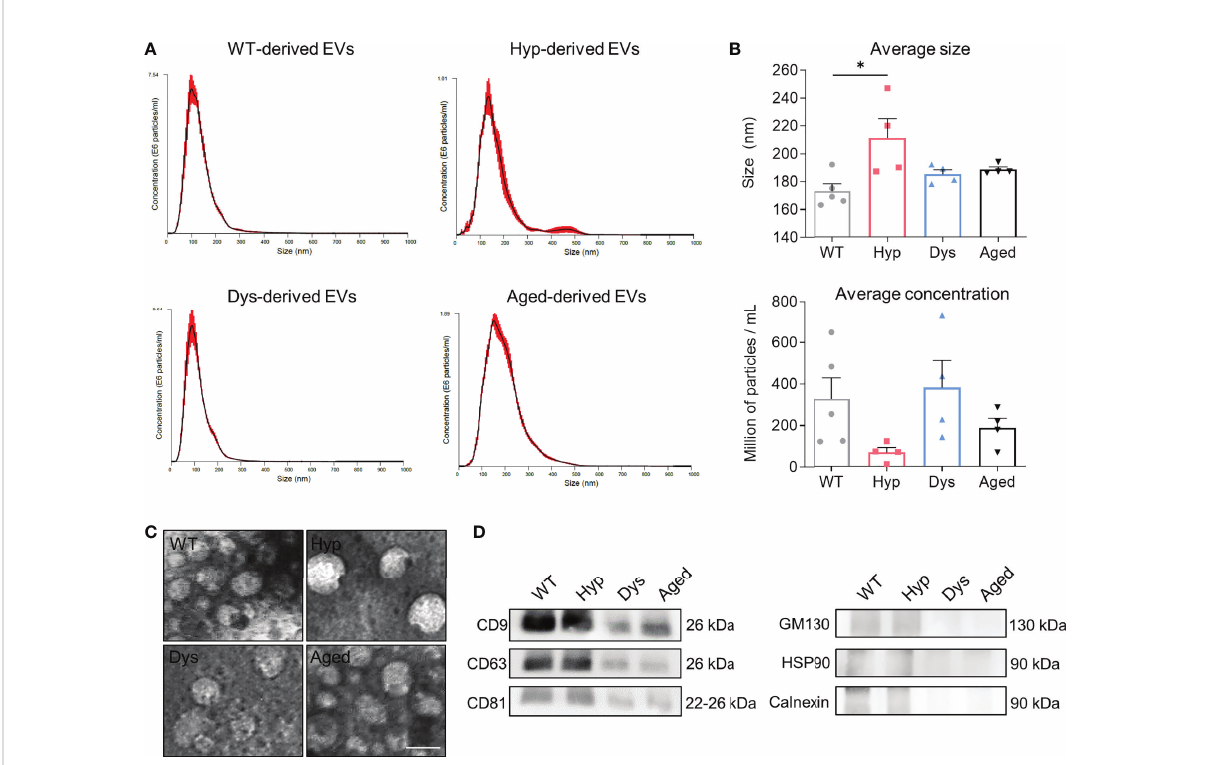
FIGURE 1 Characterization of extracellular vesicles derived from the plasma of different mouse models. (A) NanoSight analysis of the obtained extracellular vesicles (EVs), representative graphs of particle sizes in wild type (WT)-, hypertrophic (Hyp)-, dystrophic (Dys)-, and aged-derived EVs are shown. (B) Average size (upper graph) and concentration (lower graph) of EVs. One-way ANOVA was used and results are displayed as mean±s.e.m (n=4 samples/group, EVs from 2-3 mice/sample; *p < 0.05). (C) Transmission electron microscopy analysis of EVs. Scale bars: 100 nm. (D) Western blot analysis of common positive (CD9, CD63, CD81) and negative (GM130, HSP90, Calnexin) markers for EVs and/or